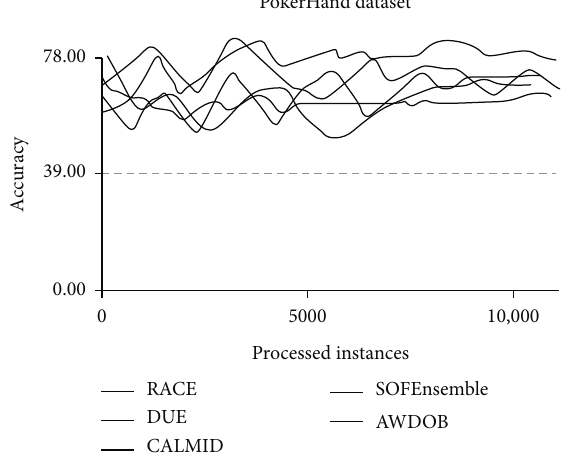
Figure 10: Prediction accuracy of the five algorithms on the Poker Hand dataset.